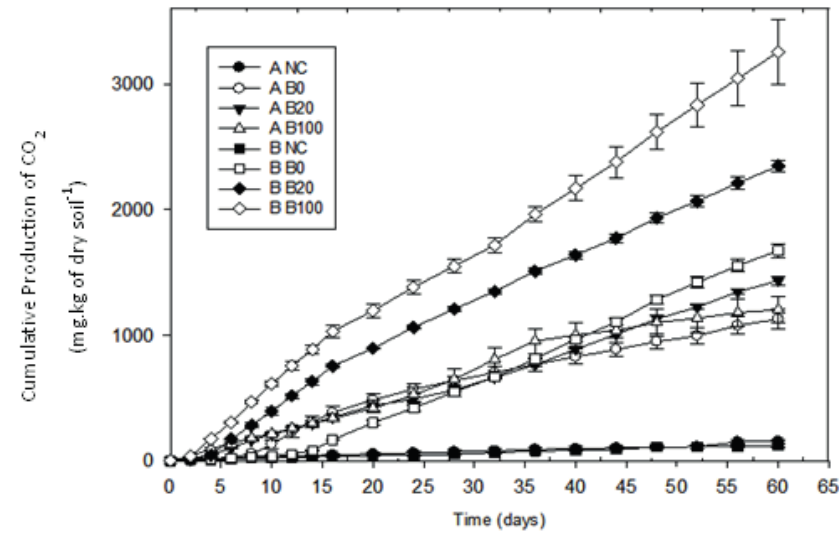
production from an ultisol contaminated by different Figure 1 - Cumulative CO 2